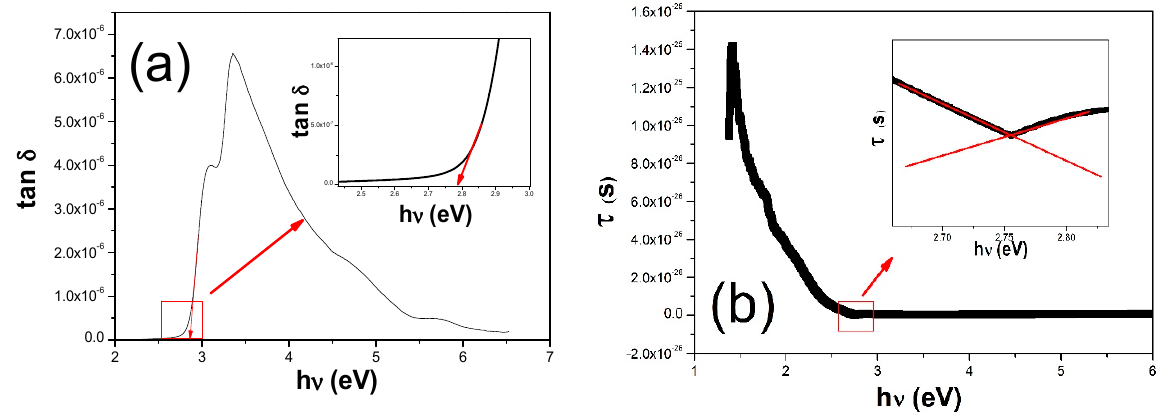
Figure 5. ( a ) the dissipation factor tan δ ( b ) the dielectric relaxation time τ as a function of the energy (h ν ). The dielectric relaxation time τ allows to confirm the value of the optical bandgap Eg